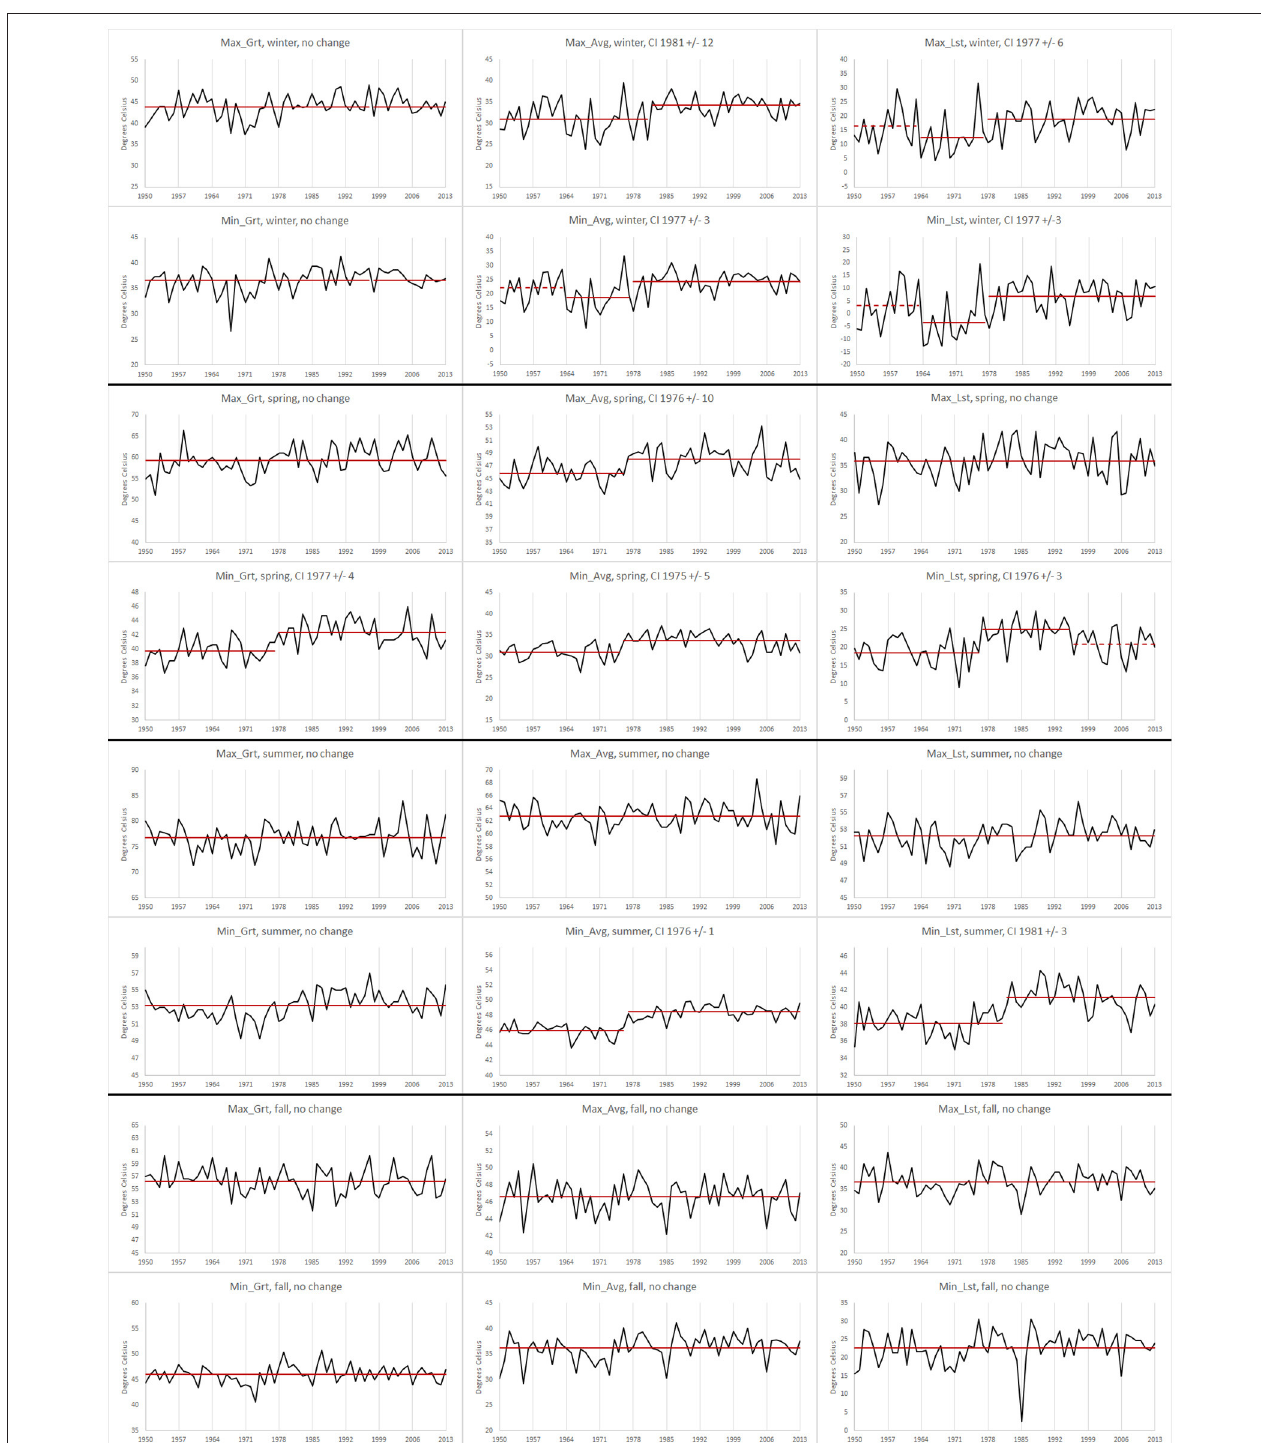
FIGURE 3 | JIA temperature data series for the time-period 1950–2013 for variables Max_Grt, Min_Grt, Max_Avg, Min_Avg, Max_Lst, and Min_Lst for winter ( A : Rows 1–2), spring ( B : Rows 3–4), summer ( C : Rows 5–6), and fall ( D : Rows 7–8) together with data means within each segment, where each segment is determined by change-point analysis; solid red lines represent data means within each segment with shifts identified by both the PELT method and the change detection test statistic; dashed red lines indicate data means for segments identified by PELT method but not confirmed by the change detection static when at least one other change is detected by